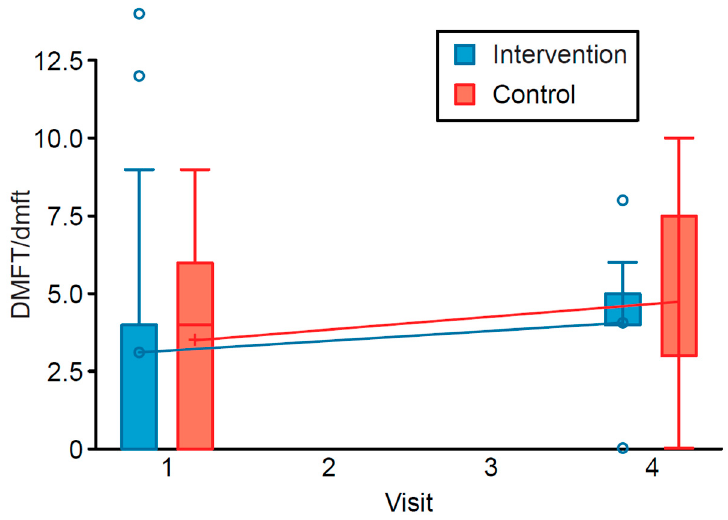
Figure 2. Distributions of DMFT/dmft scores in the intervention and control groups before and after the administration of the intervention program.